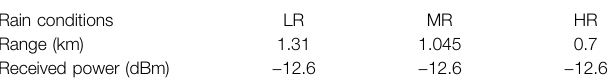
TABLE 7 | Maximum propagation ranges and received power under different rain conditions with log (BER) < − 2.5 Rain conditions